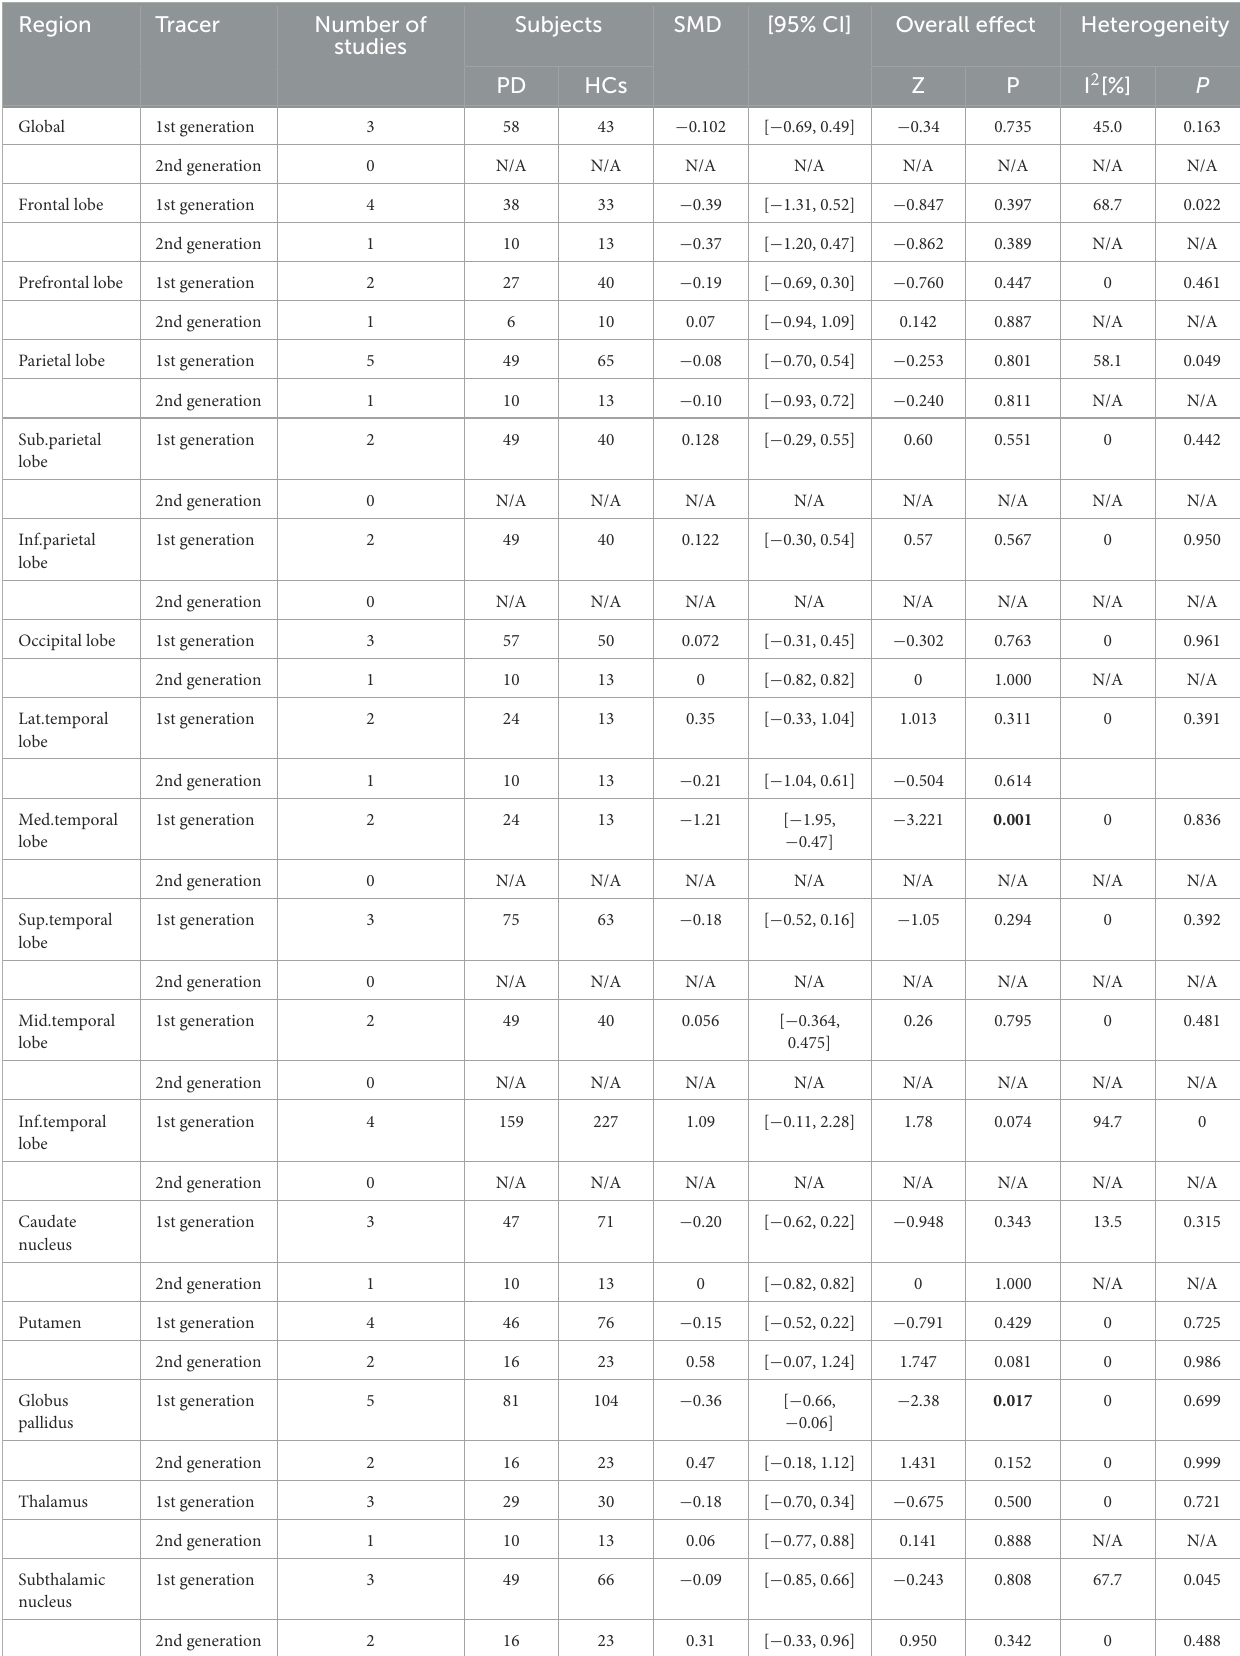
TABLE 3 Subgroup analysis based on the type of tau tracer used for studies involving PD and HCs subjects. Region Tracer Number of Subjects SMD [95% CI] Overall effect Heterogeneity studies